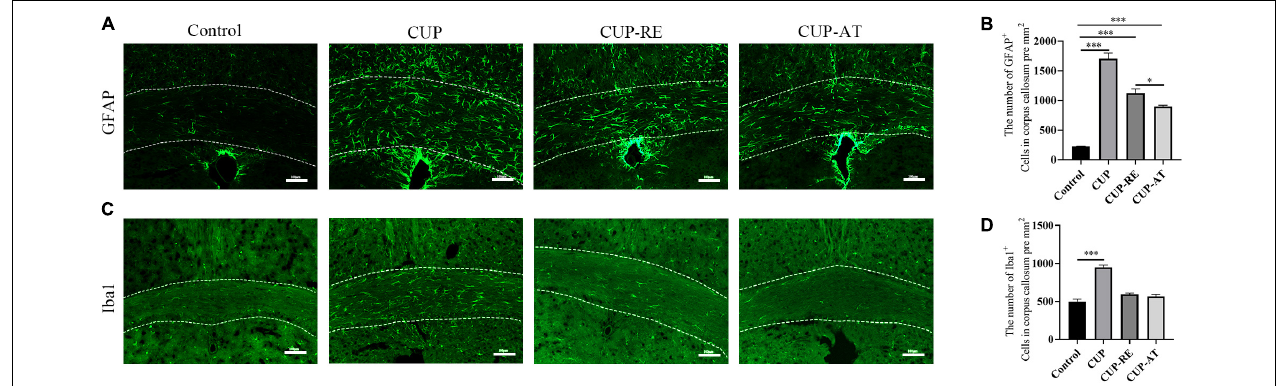
FIGURE 5 | Supplementation with Acer truncatum oil inhibited the activation of microglia and astrocytes after administration with CUP. (A) GFAP immunofluorescent staining (green) was performed in coronal slices of the corpus callosum. In control mice, astrocytes were only sporadically observed. CUP induced an increase in the number of astrocytes and cytosolic hypertrophy, which were attenuated by Acer truncatum oil supplementation. (B) Quantitative analysis of GFAP-positive cells in the corpus callosum. CUP administration significantly increases the number of astrocytes, dietary supplementation of Acer truncatum oil significantly decreased the number of GFAP-positive cells. n = 4/group. (C) Iba1 immunofluorescent staining (green) was performed in coronal slices of the corpus callosum. In control mice, microglia were only sporadically observed. CUP induced an increase in the number of microglia, which were attenuated by Acer truncatum oil supplementation. (D) Quantitative analysis of Iba1-positive cells in the corpus callosum. CUP administration significantly increased the number of astrocytes, supplementation of Acer truncatum oil decreased the number of astrocytes cells. However, the difference was not significant. n = 4–6/group. Data were expressed as means ± SEM. Differences between groups were expressed as ∗ p < 0.05, ∗∗∗ p <